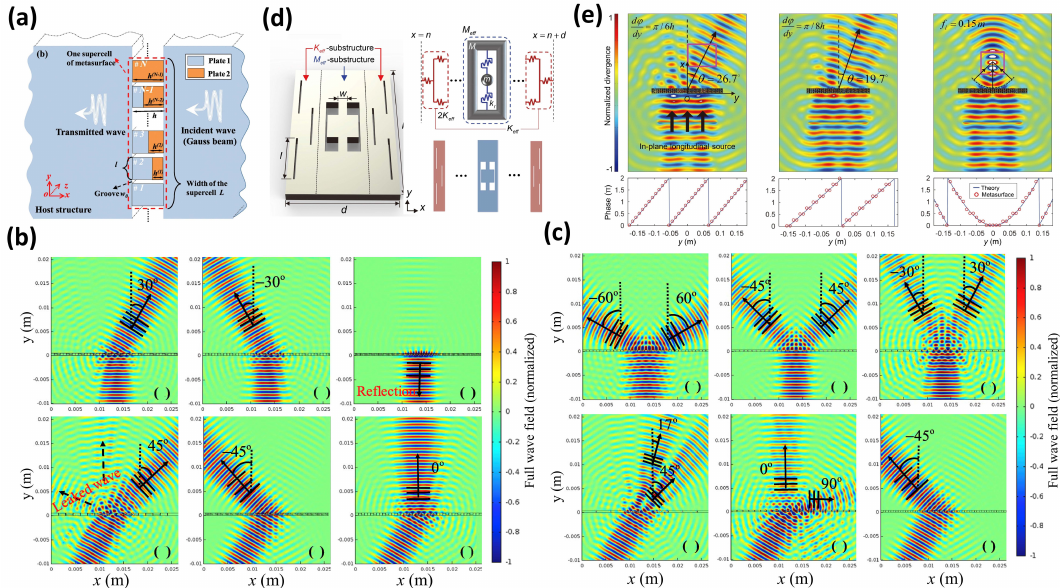
Figure 12. ( a ) Schematic of the MS. L , l , w 0 are the widths of the supercell, subunit, groove, respectively and h is the thickness of MS; ( b ) Numerical simulations of the wave field of the MS composed of four subunits. Upper side: vertical incident wave. Below side: oblique incident wave (30 ◦ ). Black arrows: analytical predictions; ( c ) Numerical simulations of the wave field of the MS composed of two subunits. Upper side: vertical incident wave. Below side: oblique incident wave (30 ◦ ). Black arrows: analytical predictions; ( d ) Unit cell consisting of two independent substructures (left) and the mass-spring model of the unit cell (right); ( e ) Upper side: simulation of longitudinal wave with d ϕ / dy = π /6 h (left), d ϕ / dy = π /8 h (center) and simulation of focal lens with its focal length is 0.15 m (right). Lower side: corresponding theoretical and discrete phase profile of upper side. ( a – c ) adapted from [149]. ( d , e ) adapted from